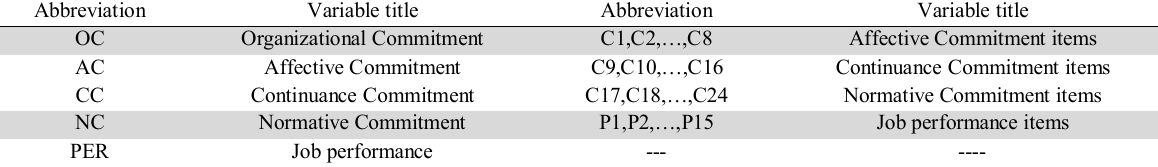
The used abbreviations symbols guide in the models